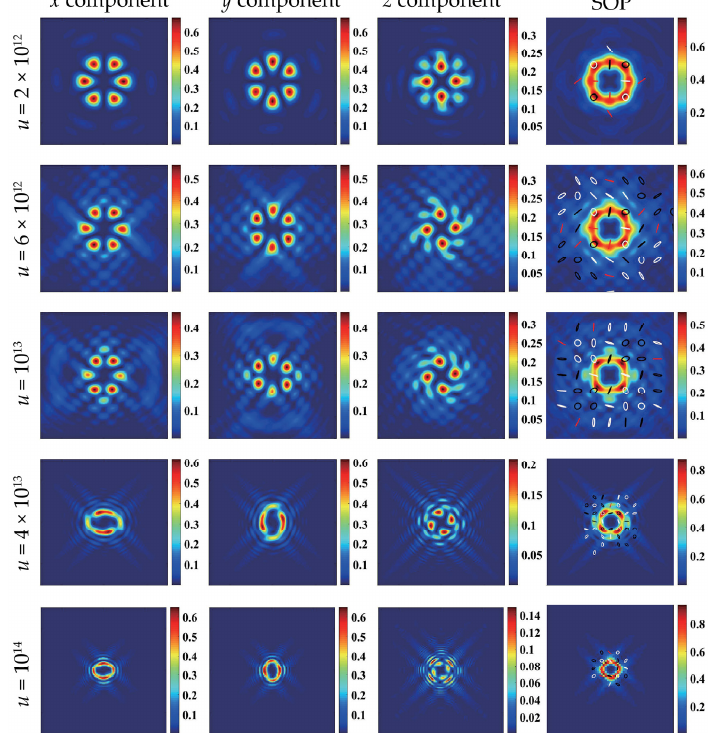
Figure 2. Intensity distributions of the TC (transverse component, x -direction, and y -direction), LC (longitudinal component), and SOP of a vector optical beam ( n = 0, m = 3, ϕ 0 = π /2 in Equation (1)) with different twisted strengths in the focal region. Here the size of each plot is 3 λ × 3 λ , the red, black, and white lines in the plots in the last column indicate the linear, left-, and right-circular polarizations, respectively.